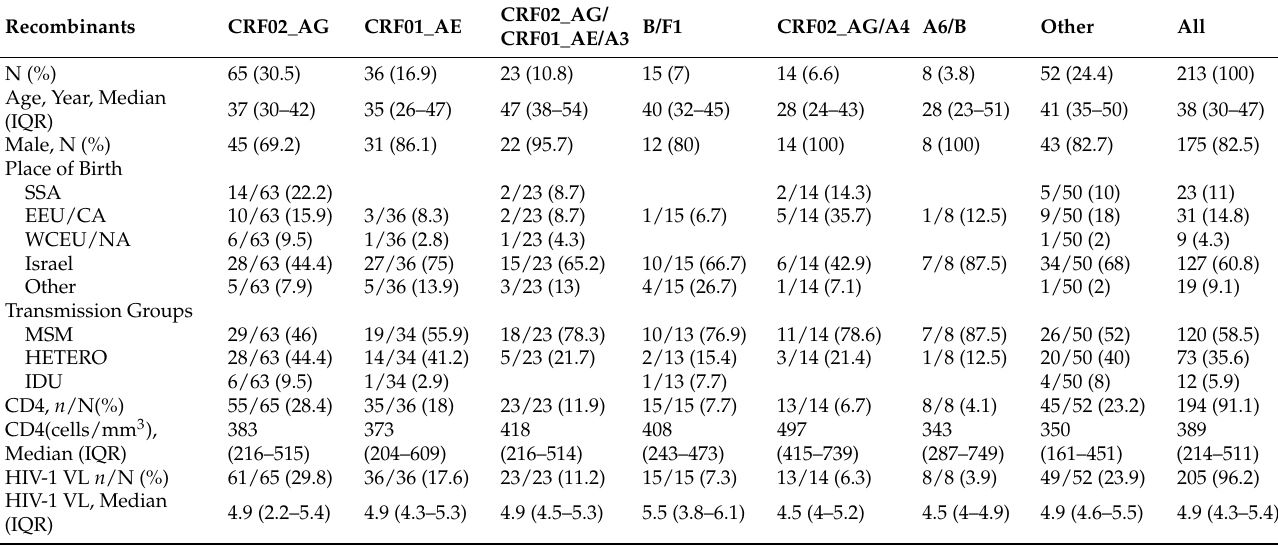
Table 1. Characteristics of patients harboring HIV-1 CRFs and